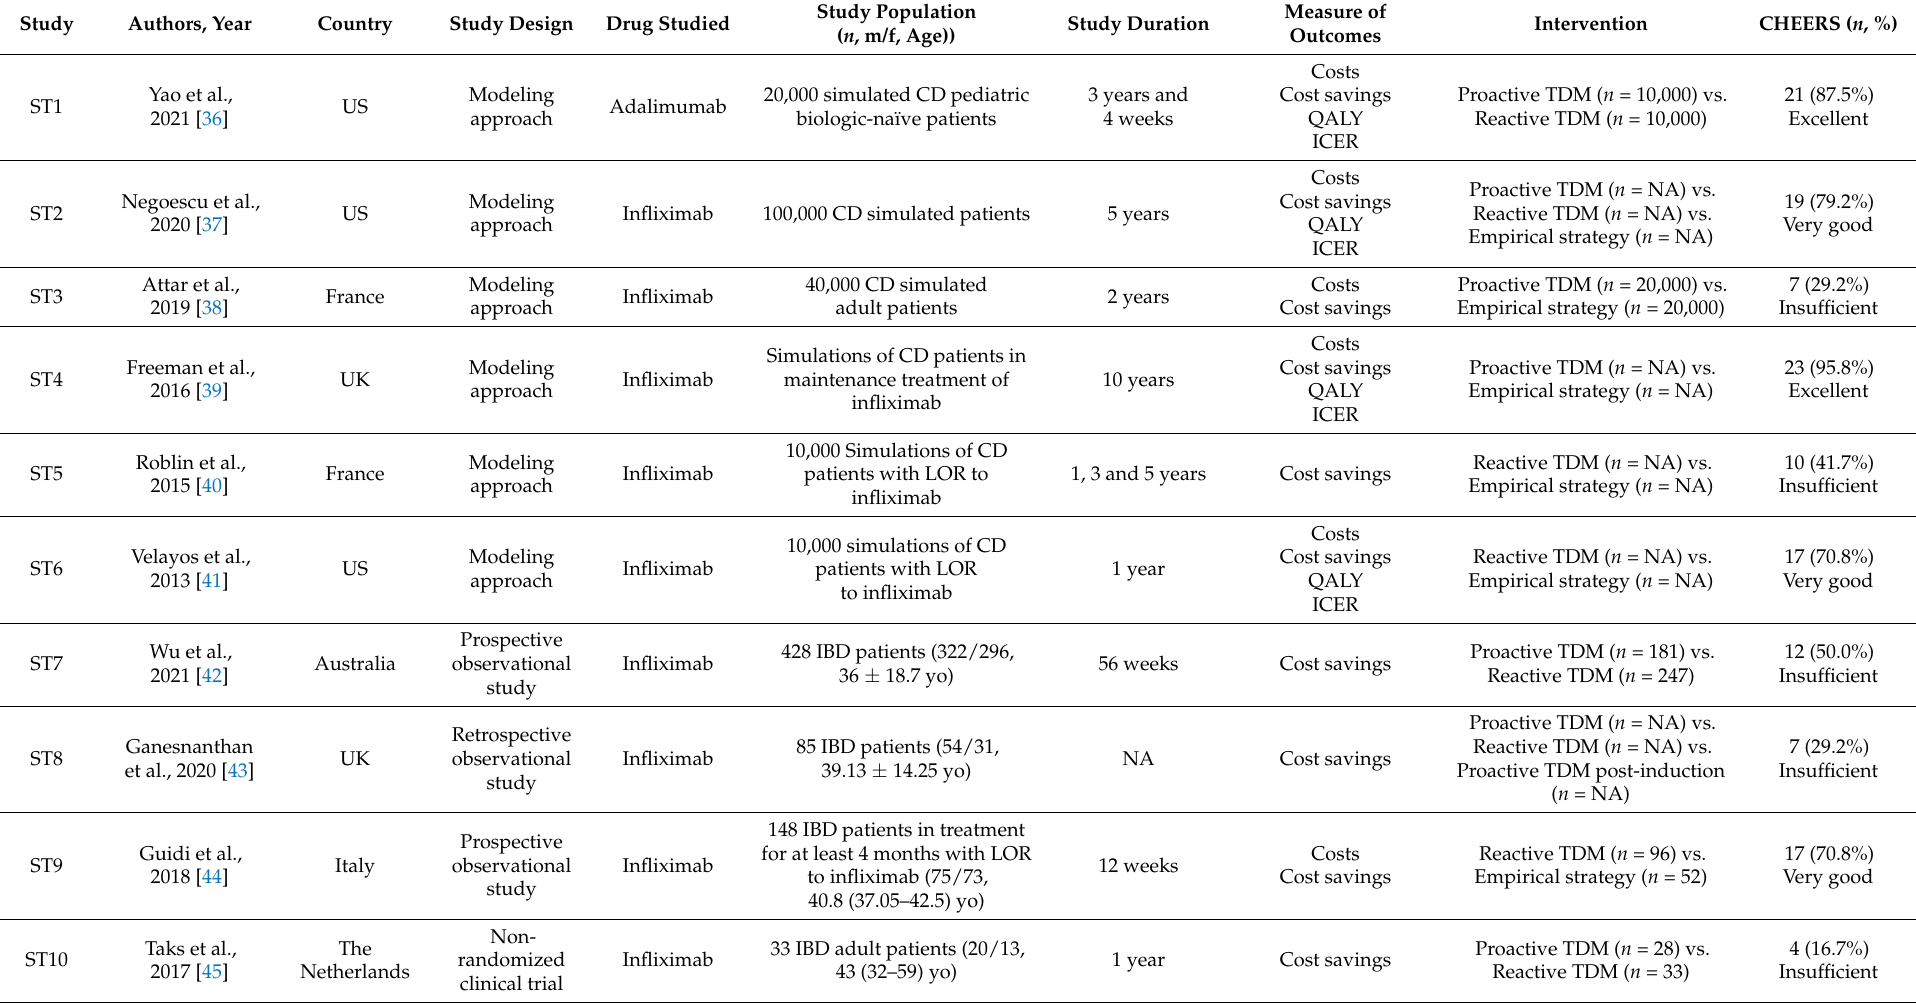
Table 1. Summary of the characteristics of the included